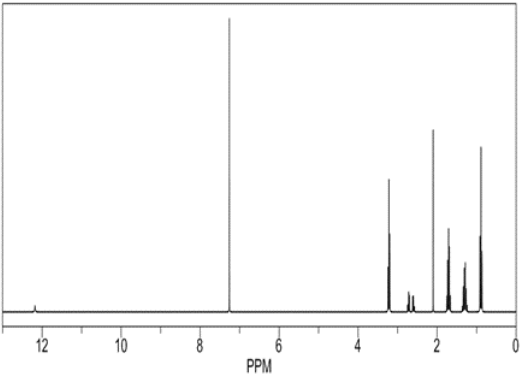
Figure 20. 1 H NMR of TBAB, LA and benzene estimated by ChemDraw.